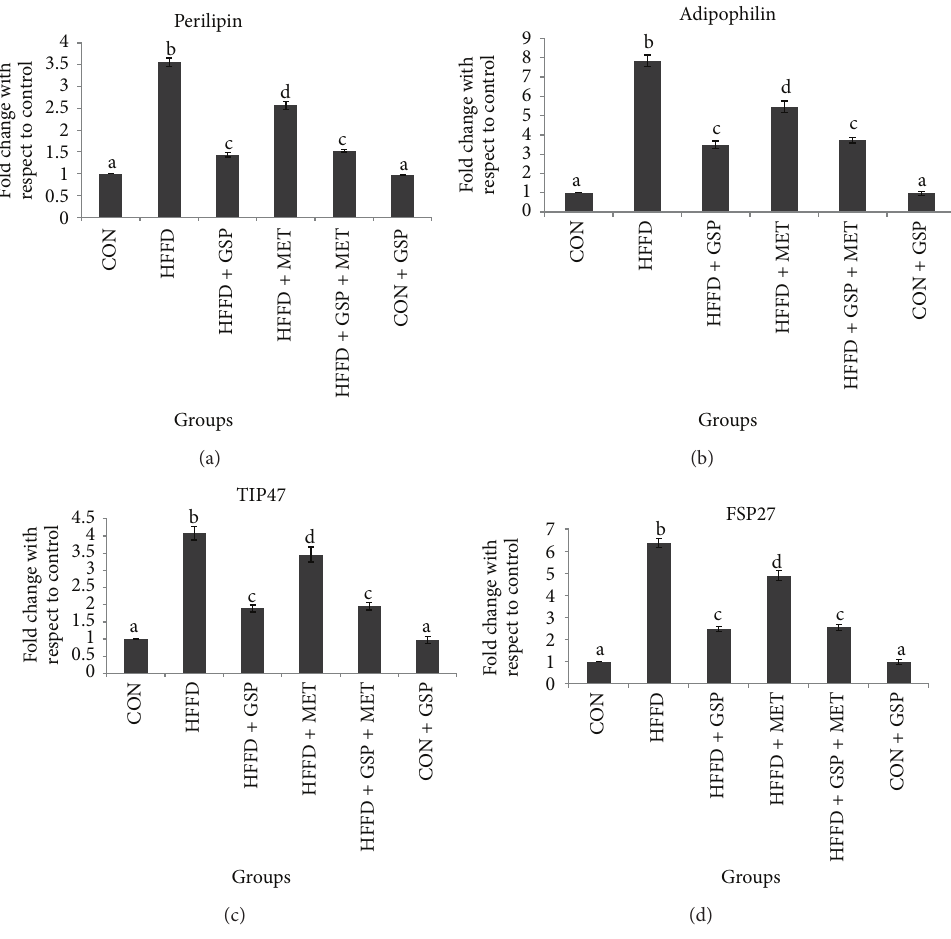
Figure 7: Effect of GSP and MET on mRNA expression of LD proteins perilipin (a), adipophilin (b), TIP47 (c), and FSP27 (d) in liver of experimental animals. Experiments were performed in triplicates and the data expressed are means ± S.D. of 3 rats from each group. The obtained Ct values of the test genes were normalized with GAPDH and expressed in bars as fold change. Statistical significance between the groups, denoted by different alphabets, was determined by one-way ANOVA of significance set at 𝑃 < 0.05